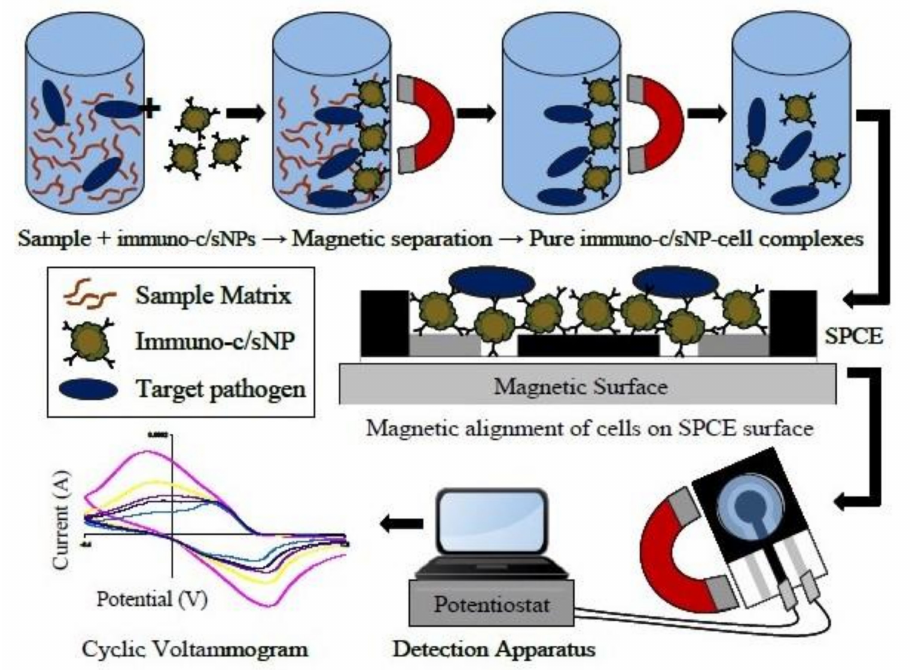
Figure 3. Immunomagnetic separation from sample matrix, magnetic alignment on SPCE surface and electrochemical detection of B. cereus cells (from